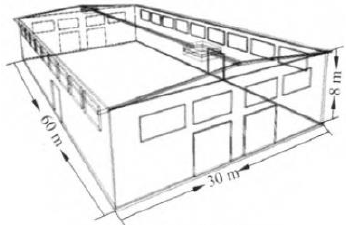
Figure 3. Geometry of the steel factory building.